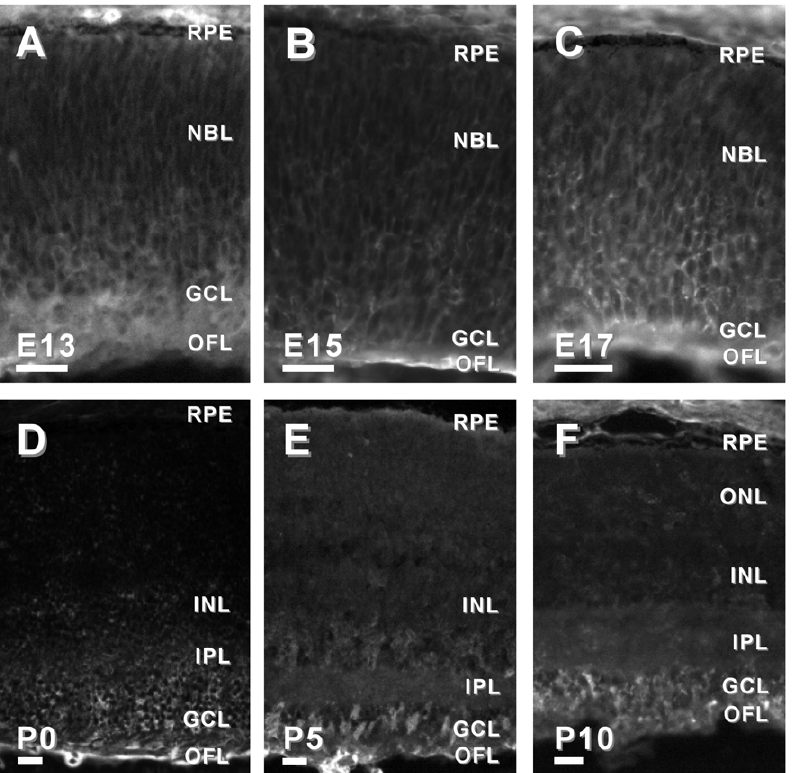
Figure 4. Dynamic protein expression of PAFAH1B3 in developing mouse retina. In the E13, E15 and E17 mouse retinas, PAFAH1B3-IR was observed throughout the thickness of the retina, though was slightly more intense in the cells of the inner retina (A–C). However, in the P0 retina, PAFAH1B3-IR was restricted to the GCL and OFL (D). PAFAH1B3-IR in the P5 retina was further restricted to a subset of cells in the GCL and the OFL (E). Pafah1b3-IR in the P10 retina was decreased to a punctate pattern in the GCL (F). Abbreviations same as in Figure 2. Bars, 30 m m.